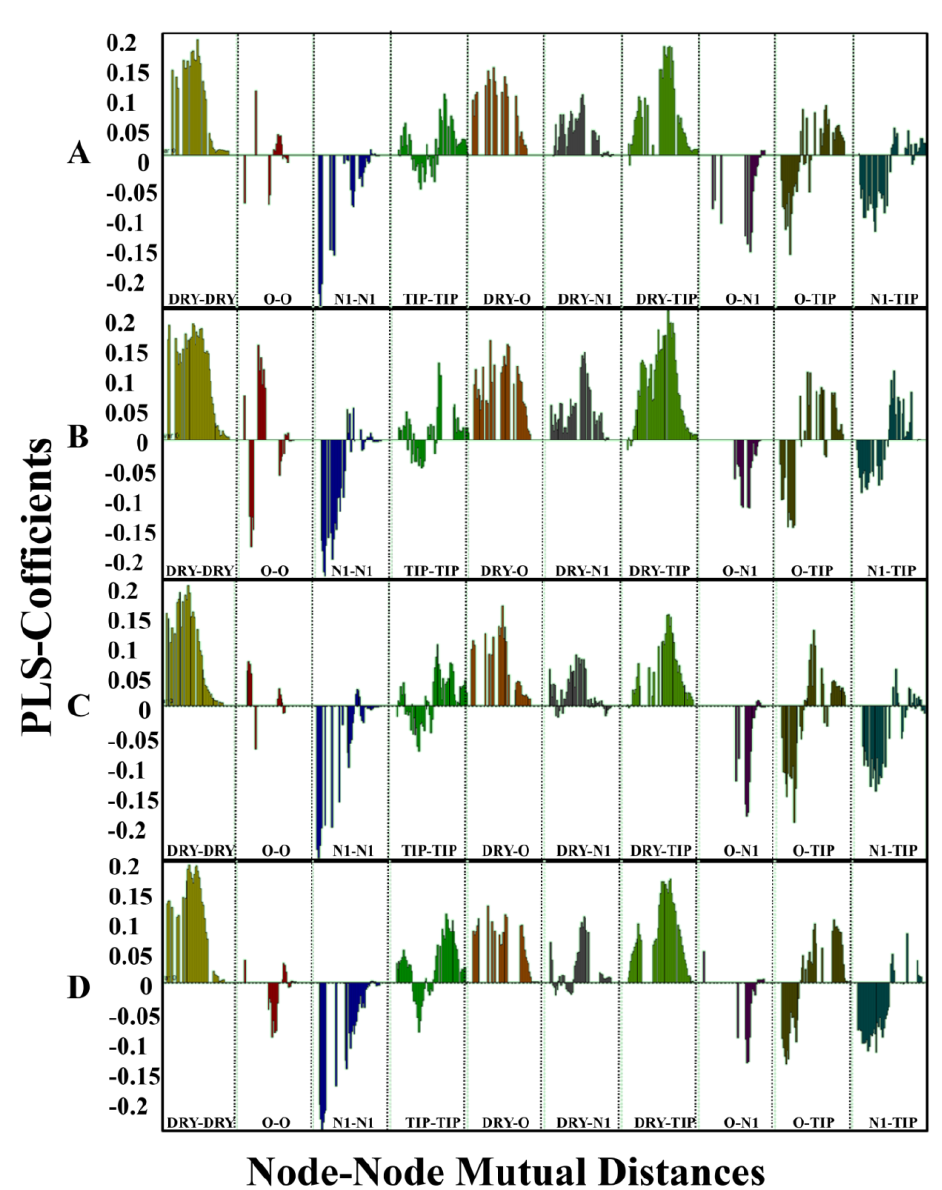
Figure 10. Partial least square (PLS) coefficient plots. ( A ) Non-solvated-open state conformations. ( B ) Solvated-open state conformations. ( C ) Non-solvated-closed conformations. ( D ) Solvated-closed conformations. Indicating DRY-DRY yellow contour, DRY_TIP green contour and DRY-O brown contour present at particular distance increase the tendency of a compound to trap in hERG binding cavity, However, N1-N1 blue contour represents two hydrogen bond donor feature and O-TIP turquoise contour representing one hydrogen bond acceptor and a steric feature present at particular distance impact negatively towards hERG inhibition potential of compounds.